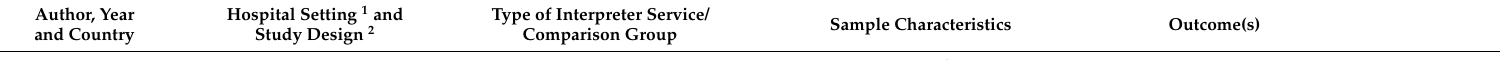
Table 3. Interpreter service usage and the communication quality between patients and healthcare